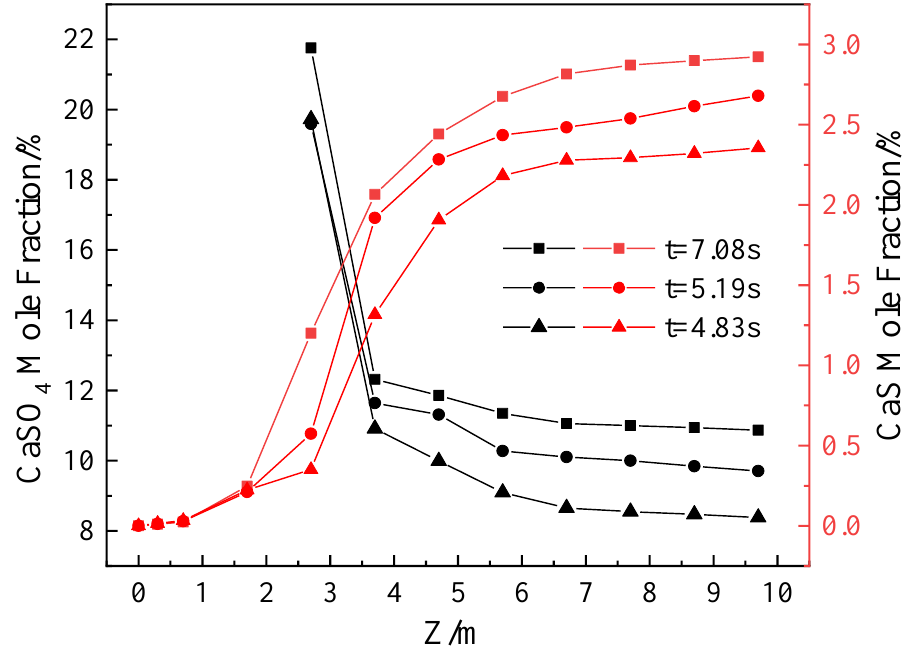
Figure 13. Curve chart of average molar fraction of solid phase at each section of Z-axis for different particle retention times.